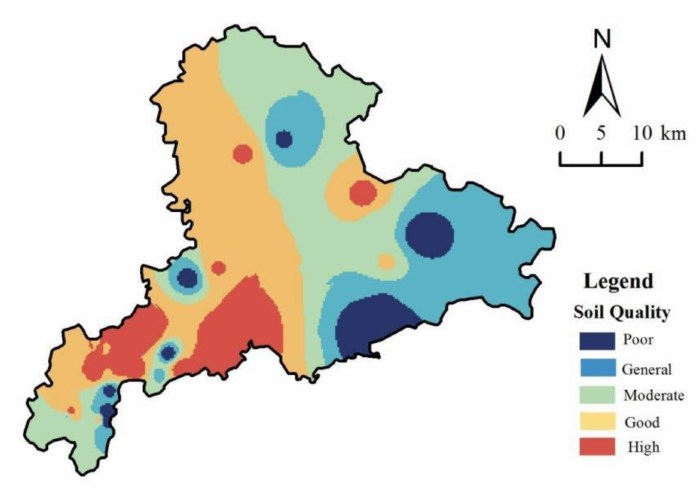
Figure 6. Spatial distribution of comprehensive soil